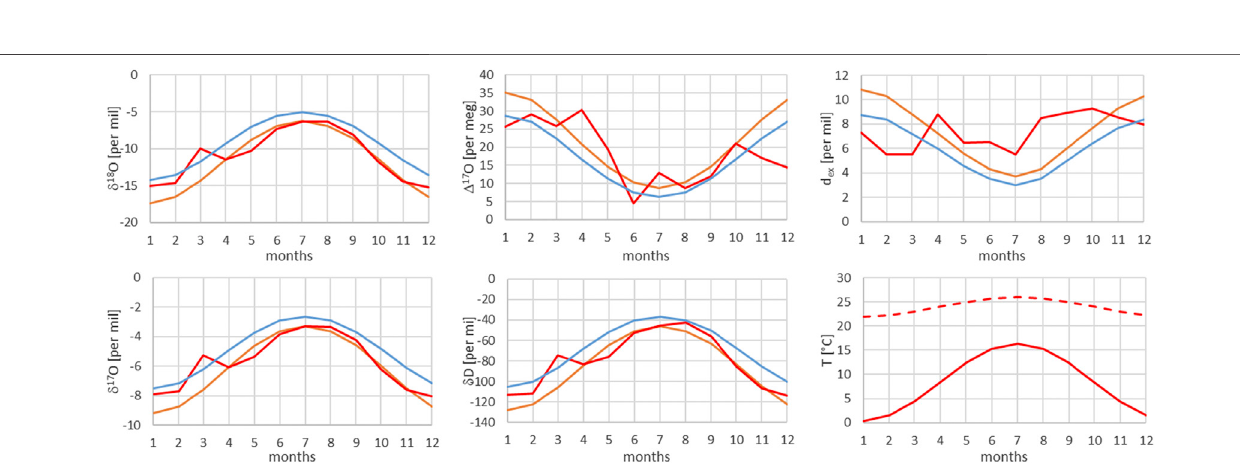
FIGURE 9| Comparison ofmonthly mean measured (red) and modeled (for theisobaric case (orange) and for the dry adiabatic case (blue)) isotope ratios for Bern. The dashed red line corresponds to the assumed source temperature.